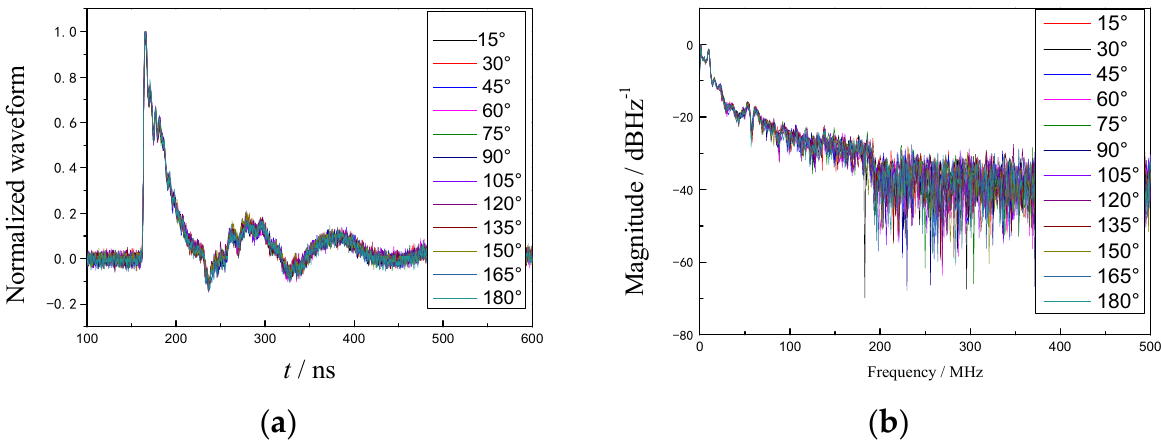
Figure 4. The normalized waveform and spectrum of the incident electric fields: ( a ) the waveform; ( b ) the spectrum.